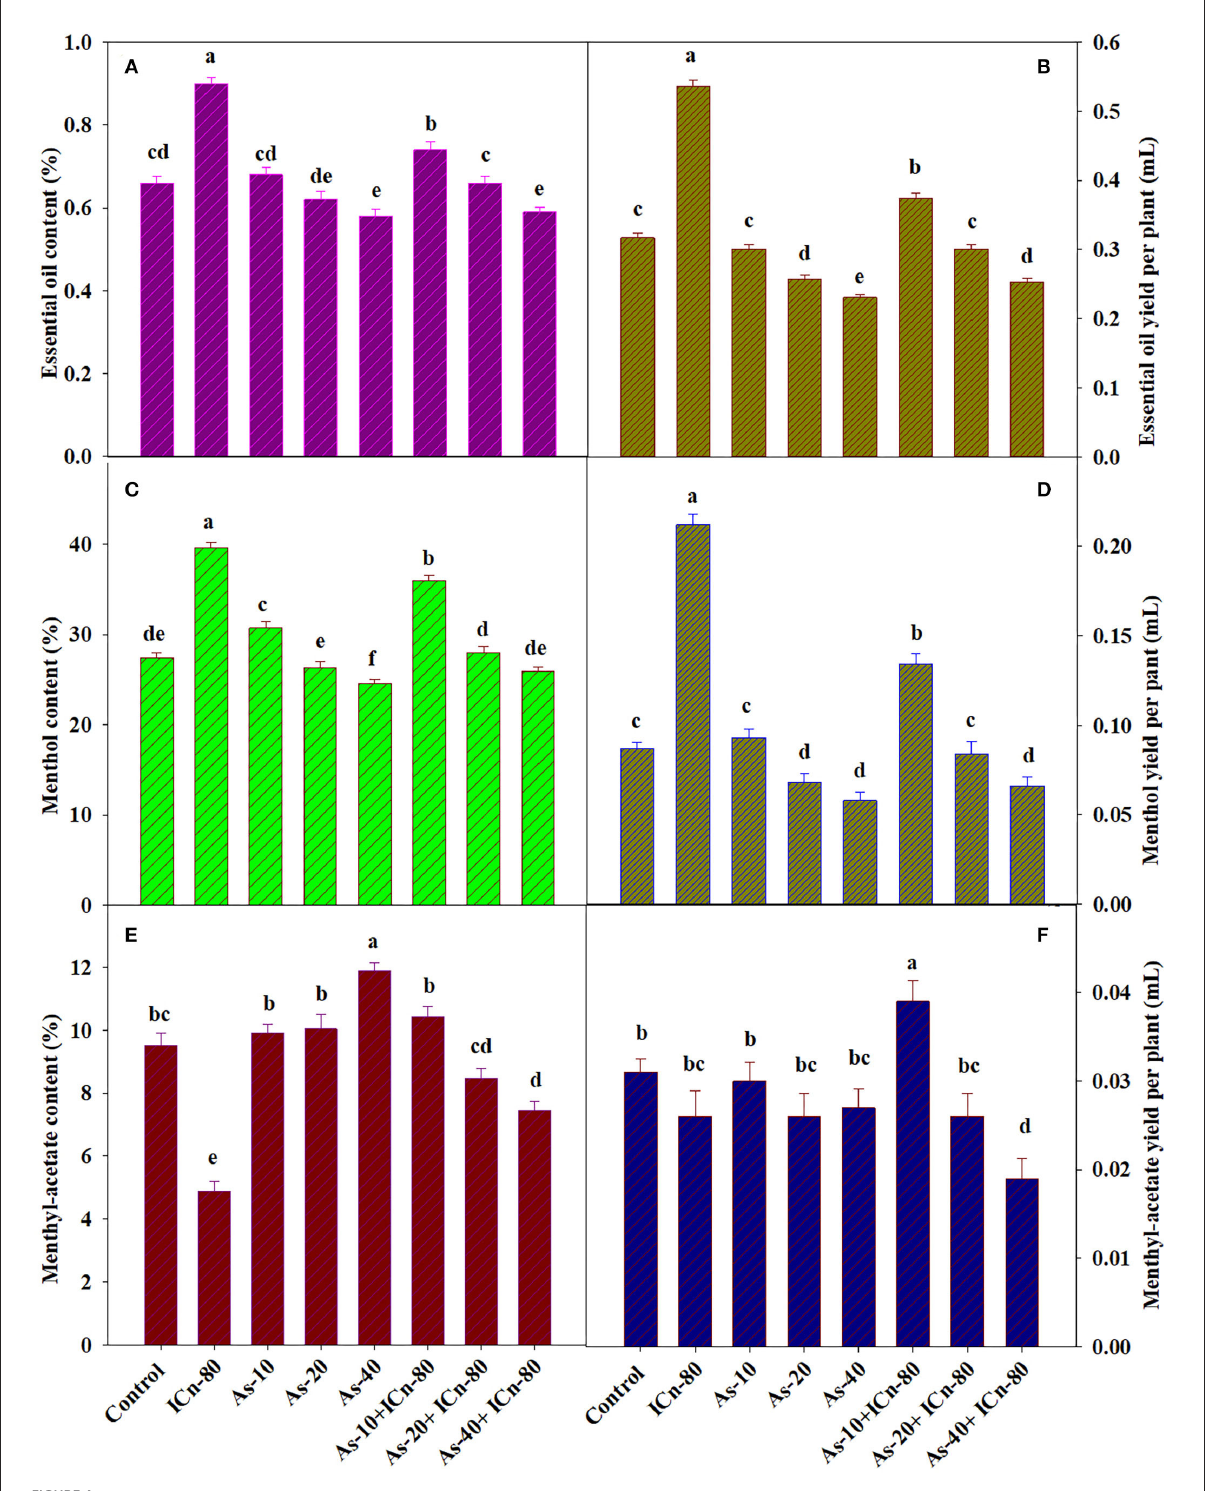
FIGURE4 Essential oil content (A) , essential oil yield per plant (B) , menthol content (C) , menthol yield per plant (D) , menthyl acetate content (E) , and menthyl acetate yield per plant (F) of peppermint ( Mentha piperita L.) at 150 days after transplanting with/without As stress (10, 20, or 40mg kg − 1 of soil, as Na 2 HAsO 4 · 7H 2 O) and treated with ICn (80mg L − 1 ). Data are presented as treatment mean ± SE ( n = 5). Bars with the same letters are not significantly different ( P <